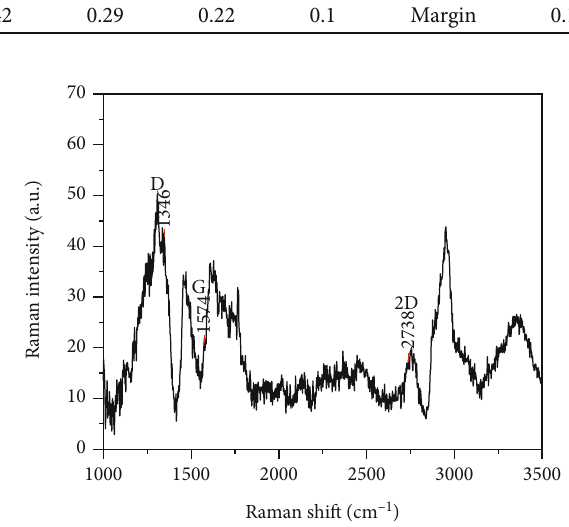
Figure 1: Raman of graphene-modi fi ed